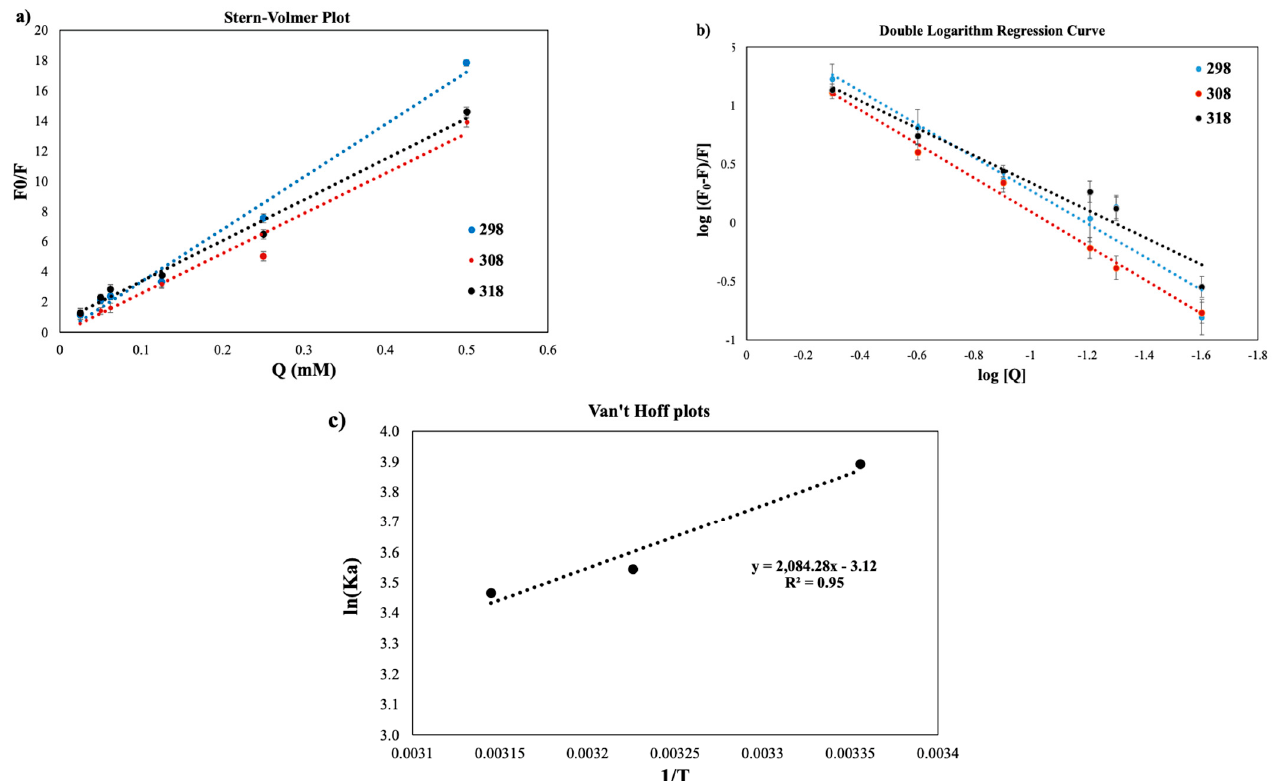
Figure 5. Stern–Volmer plots ( a ), double logarithm regression curves ( b ), and Van’t Hoff plots ( c ) for dHPI+HSE complex at different temperatures (blue: 298 K; red: 308 K; black: 318 K) to calculate the number of binding sites (n), binding constant (K A ), and thermodynamic parameters. The fraction of accessible fluorescence was calculated from Equation (9):